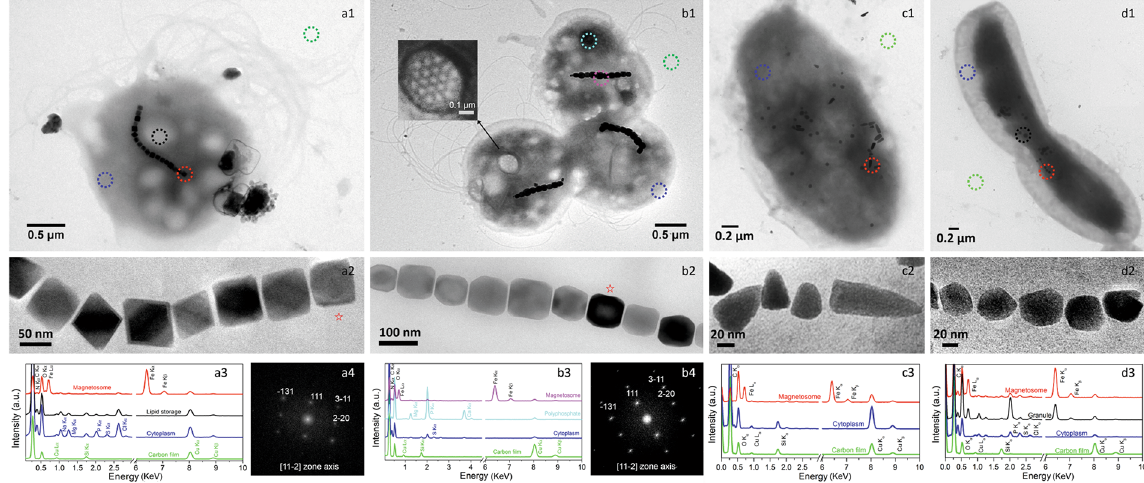
Figure 4. Seamount MTB and identification of the magnetic crystals. Panels a1 and b1: Magnetotactic cocci having single chains of octahedral and prismatic magnetite magnetosomes. Panel c1 and d1: Vibrioid MTB and dumbbell-shaped MTB. Panels a2, b2, c2 and d2: Magnified images of magnetosomes. Coloured circles indicate analysis points for the EDXS analyses shown in a3, b3, c3 and d3. Electron diffraction images of the red star magnetosomes are shown in a4 and b4. The inset in b1 shows a flagella base platform comprising 19 individual flagella that are arranged in a 3:4:5:4:3